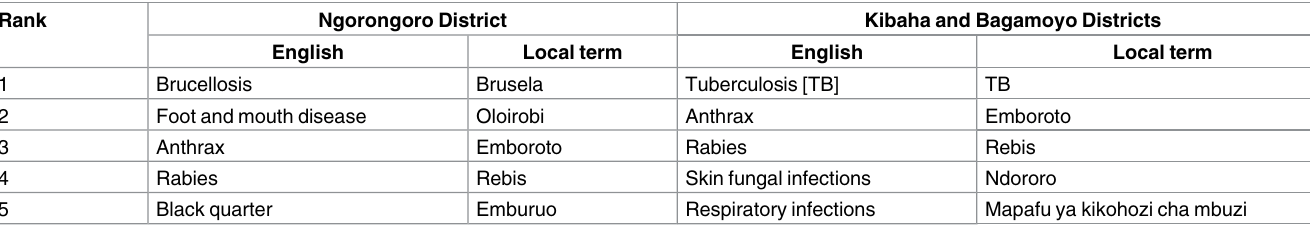
Table 6. Perceived zoonoses as ranked by all